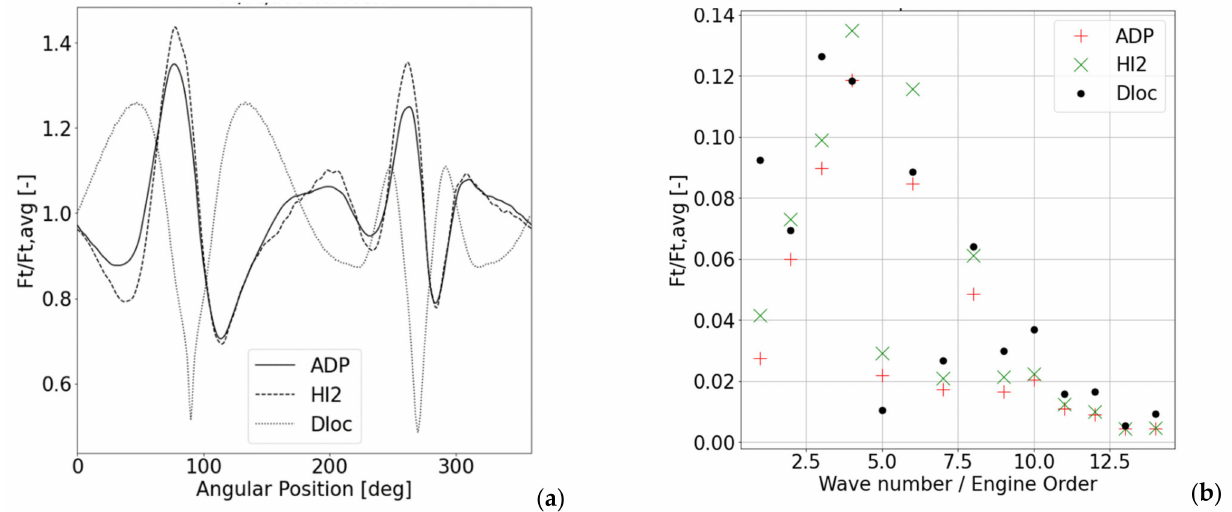
Figure 12. Blade forcing for ADP and HI2 with reference distortion Dloc. ( a ) As a function circumferential position; ( b ) Fourier component